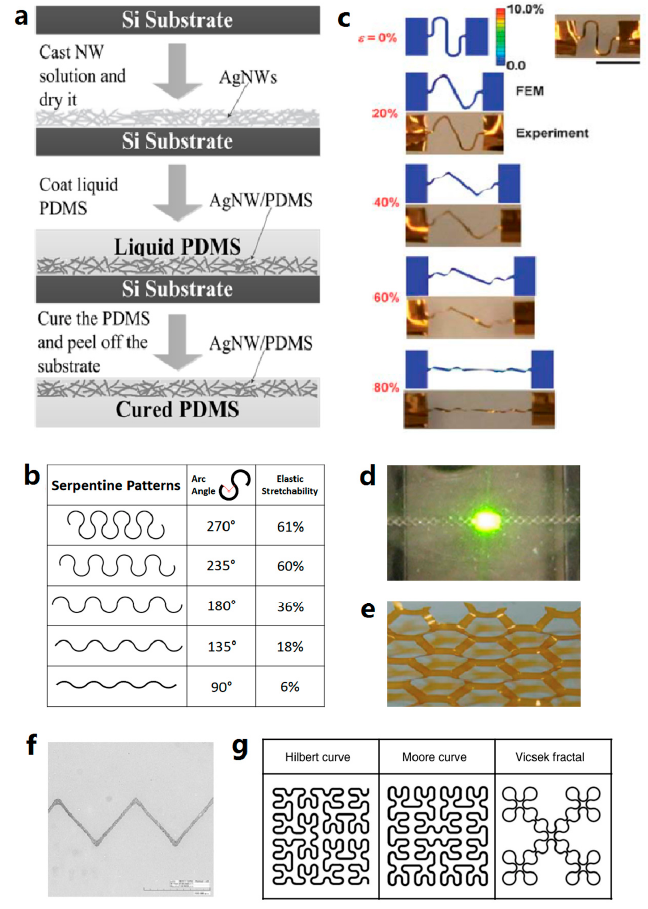
Figure 4. ( a ) Schematic of the fabrication process of an AgNW/PDMS stretchable conductor.